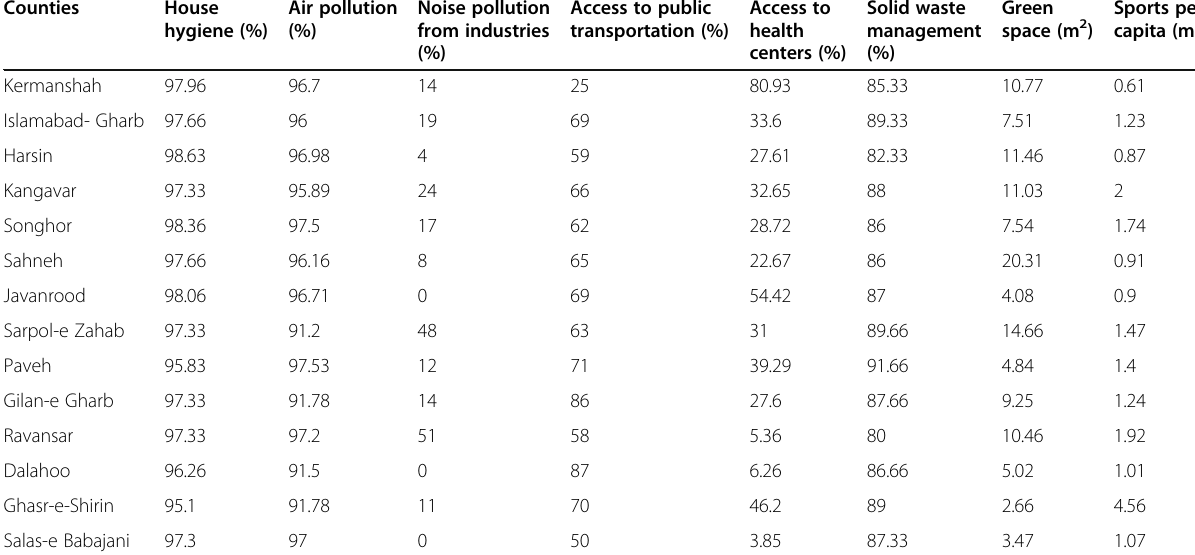
Table 2 The indexes of equity in physical environment and infrastructures across Kermanshah province, Iran Counties